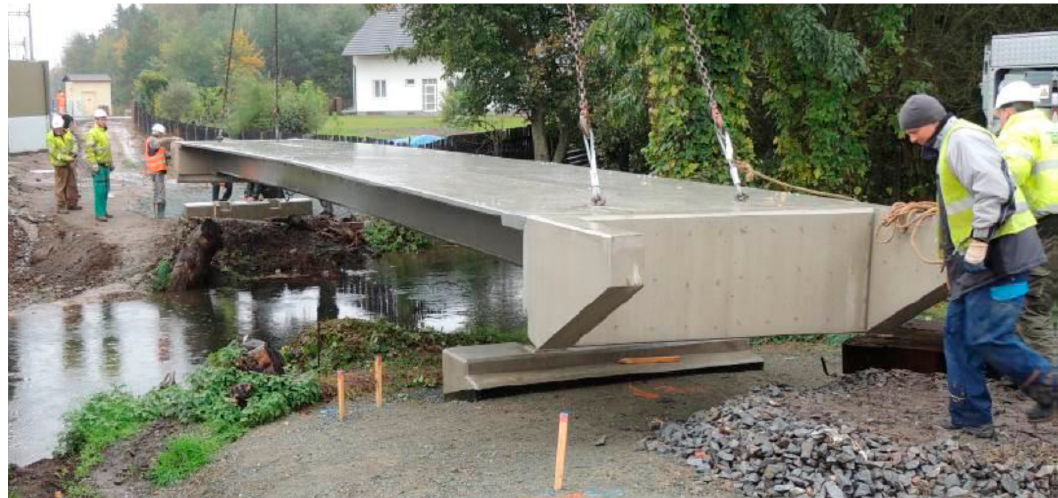
Figure 1. Installation of the prestressed ultra-high performance concrete (UHPC) girder of a beam footbridge (2015—village Ceperka across Opatovicky canal, Czech Republic).